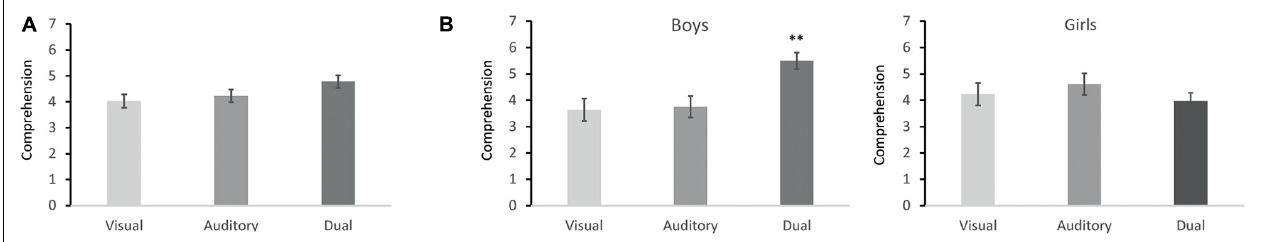
FIGURE 1 | Gender-specific language comprehension for different text presentation modalities. (A) Values represent the average score on text comprehension for each experimental group for all students. Error bars correspond to the standard error of the mean ( n = 73, 74, and 68 for visual, auditory and dual groups). ANOVA analysis showed no significant differences among the groups ( p = 0.0895). (B) Same analysis grouping boys and girls separately (** p < 0.01, Bonferroni among different modalities in